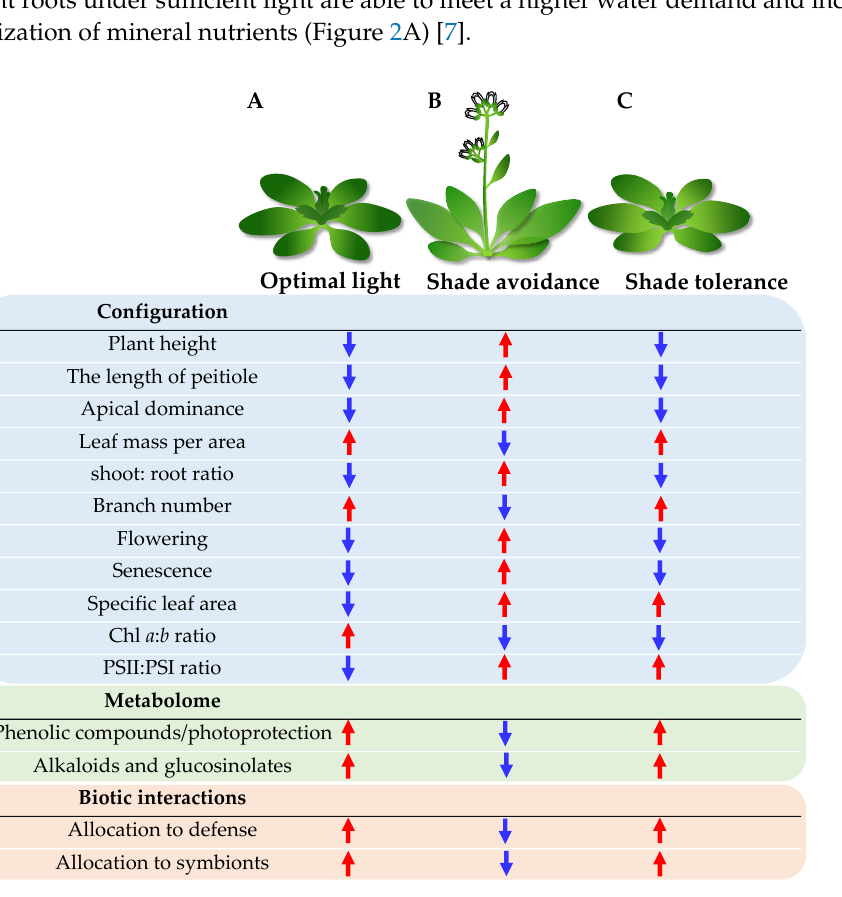
Figure 2. Physiological and biochemical responses of plants to optimal light, and suboptimal light (as in shade avoidance and shade tolerance mechanisms). ( A ) Changes in plant configuration, metabo- lites, and biotic interactions under optimal light conditions. ( B ) Changes in configuration, metabolites, and biotic interactions of shade avoiders under shading and suboptimal light. ( C ) Changes in con- figuration, metabolites, and biotic interactions of shade-tolerant species to shading and suboptimal light. Red arrows denote increasing trend, and blue arrows denote decreasing trend. See main text for details. Abbreviations: Chl, chlorophyll; PS,